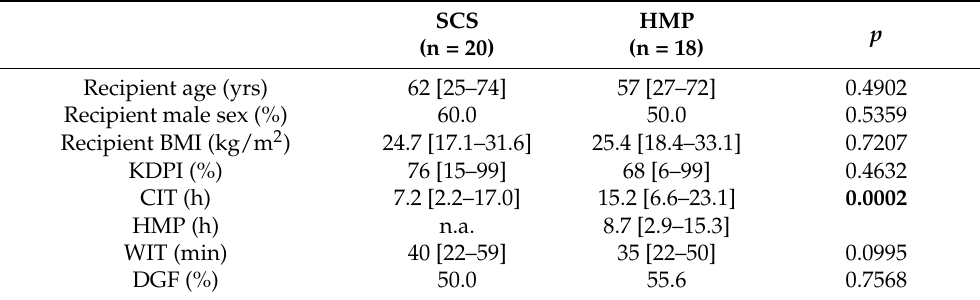
Table 1. Recipient and donor characteristics, as well as surgical details, according to organ preserva- tion